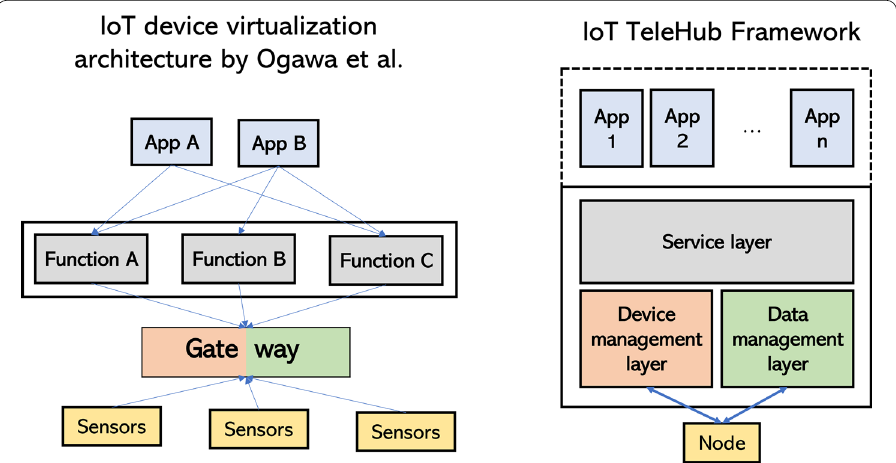
Fig. 7 Mapping of the proposed framework and the IoT device virtualization architecture in